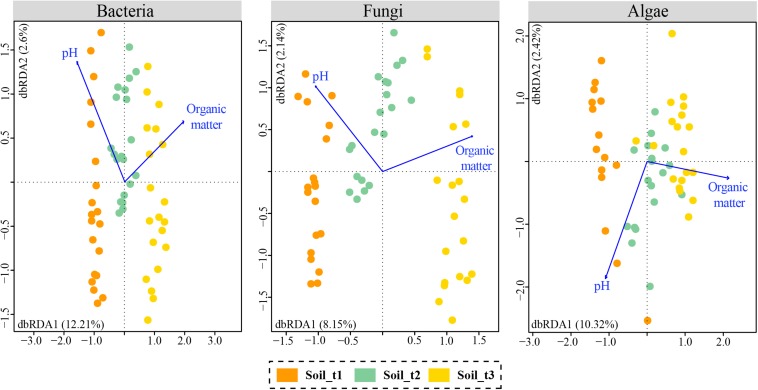
Distance based redundancy analyses (db-RDAs) with selected edaphic variables that explained most of the variability in soil communities of bacteria, fungi and algae. Samples of each of the three successional stages are colored differently.